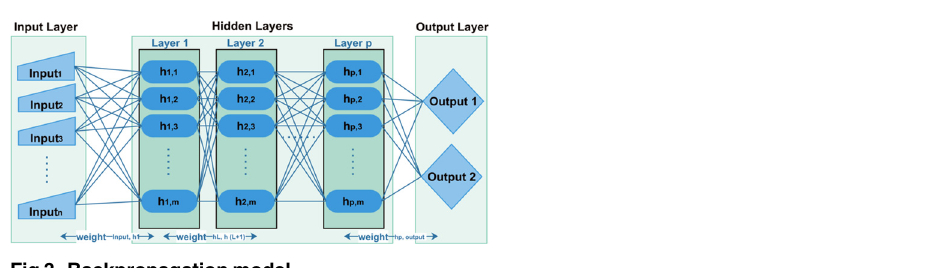
Fig 3. Backpropagation